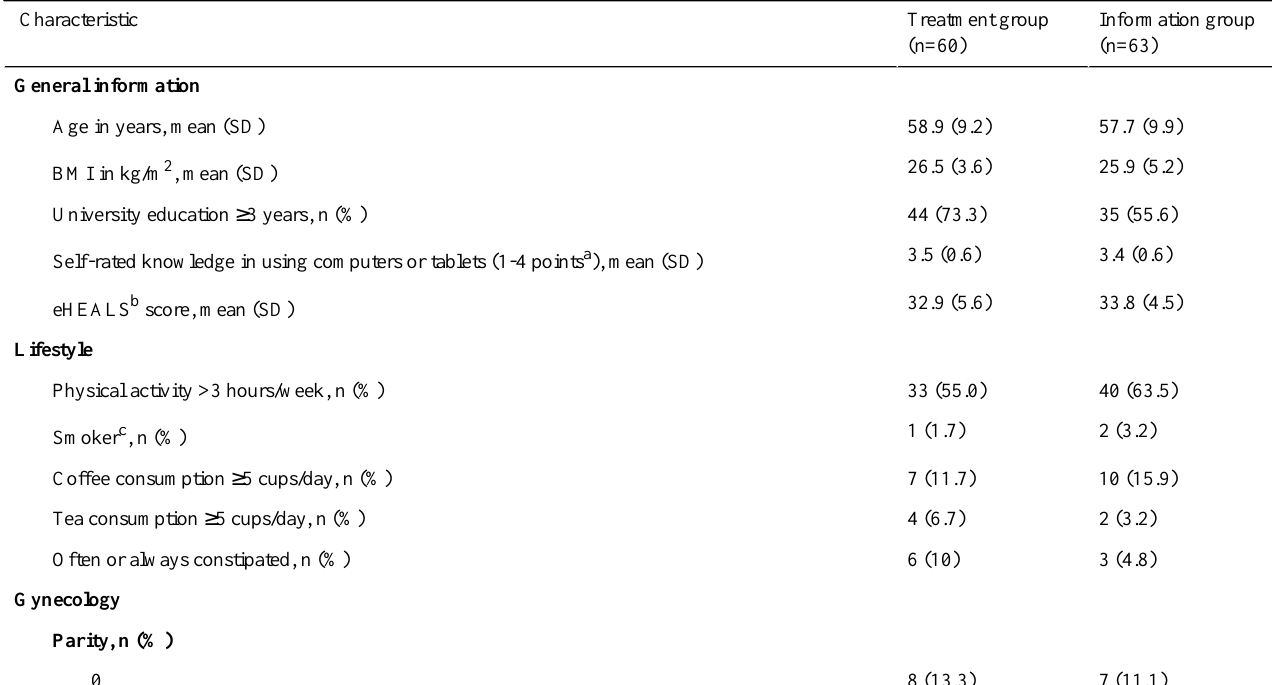
Table 2. Baseline characteristics of study